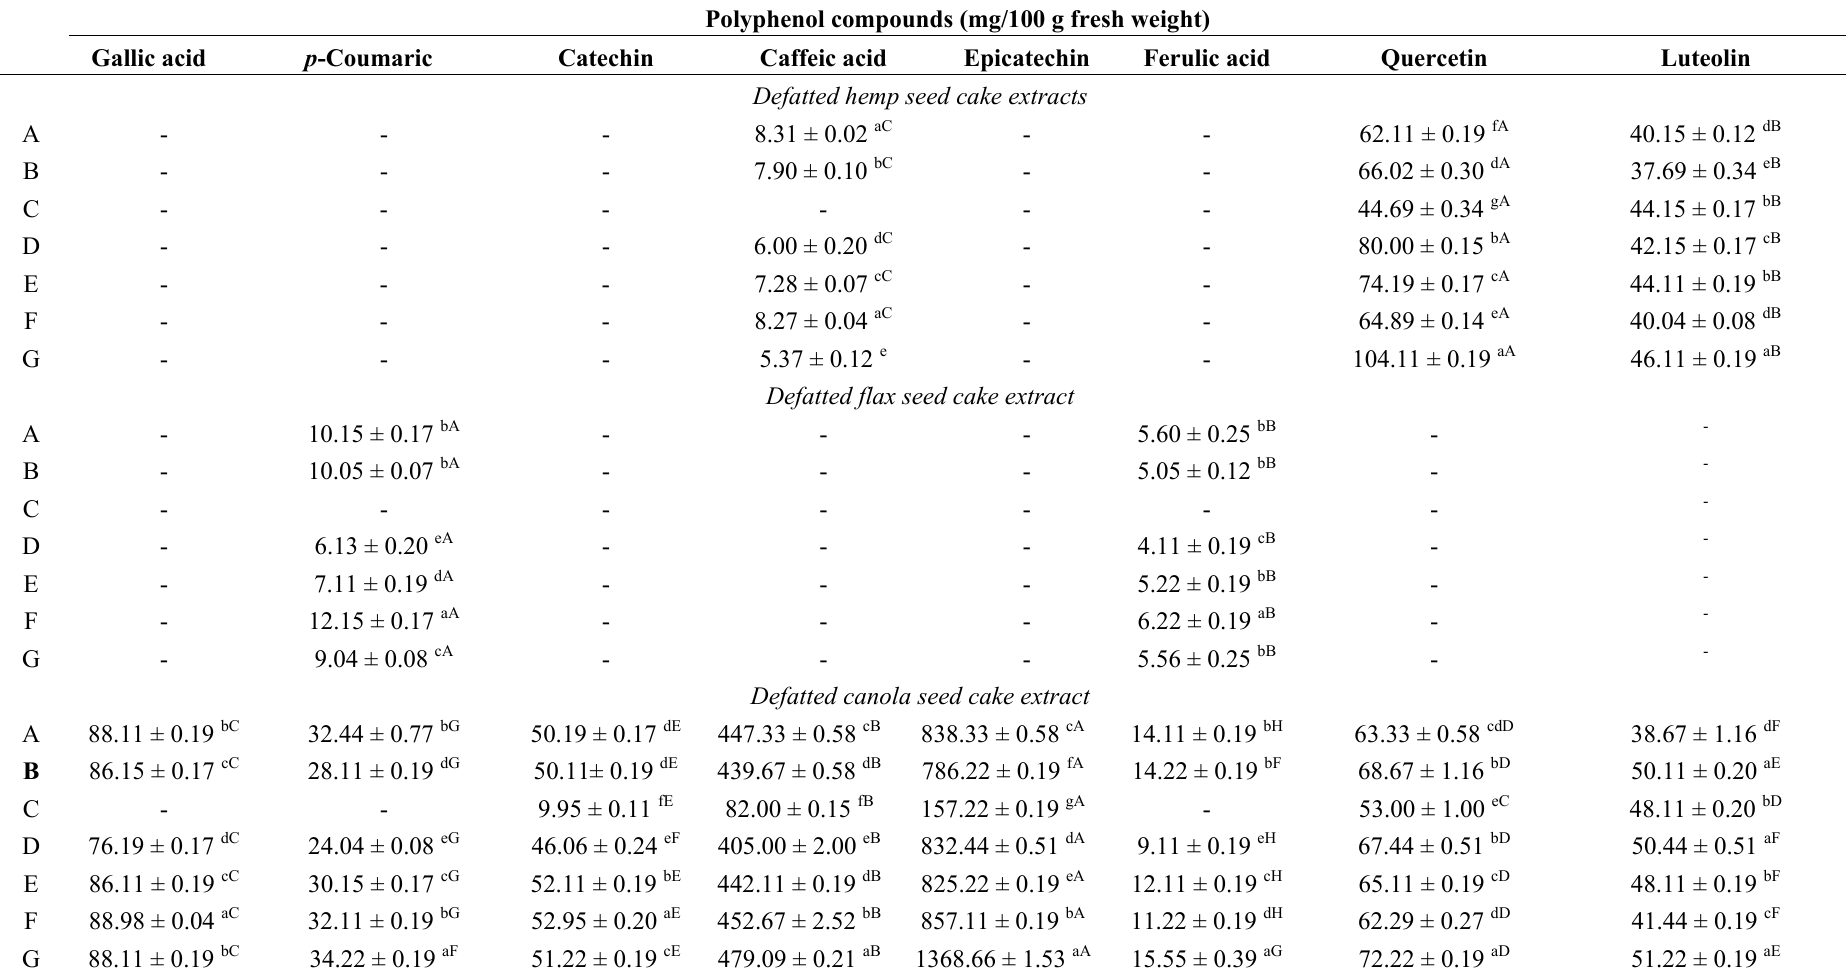
Table 5. Identification polyphenols of defatted oilseed cakes by